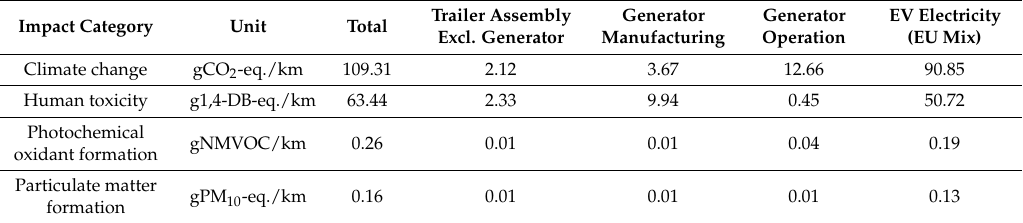
Table 5. LCIA of the 40 kWh EV + generator ReX for the various impact categories